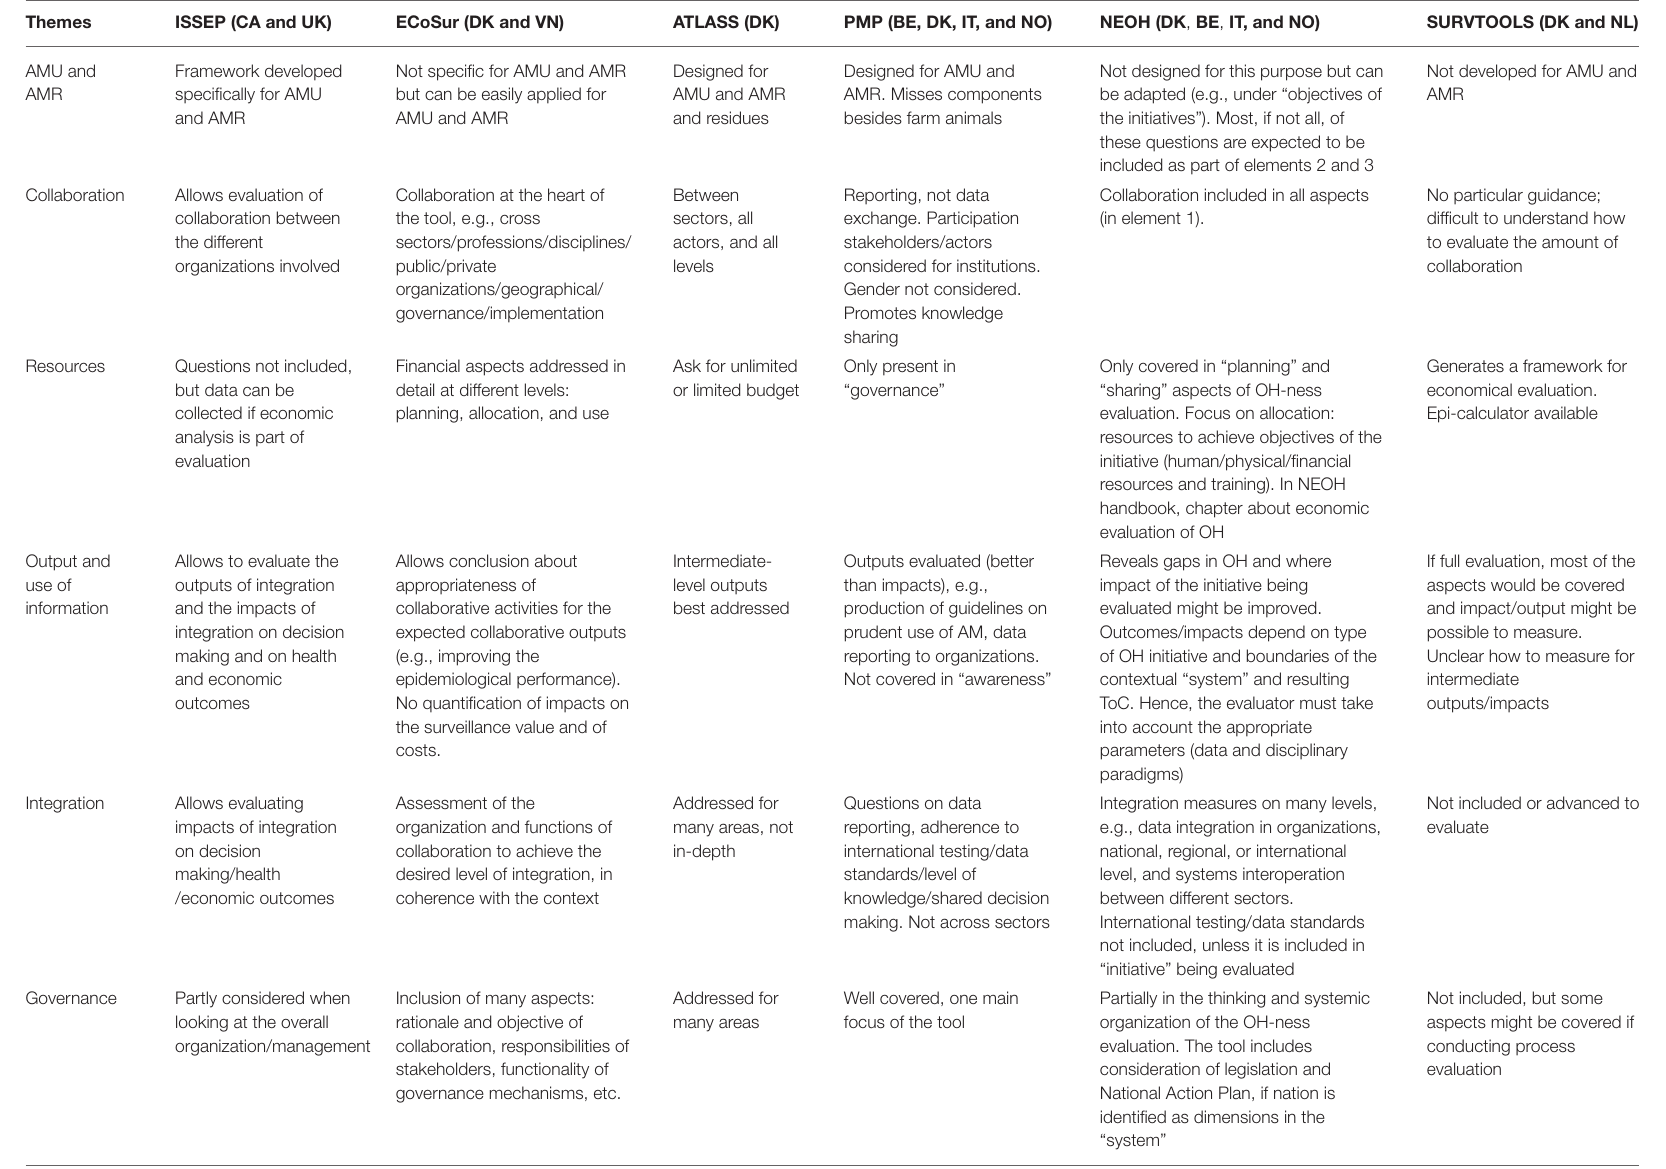
TABLE 7 | Synthesis of the underlying reasoning for the scoring according to the eight themes describing the scope of six AMR surveillance evaluation